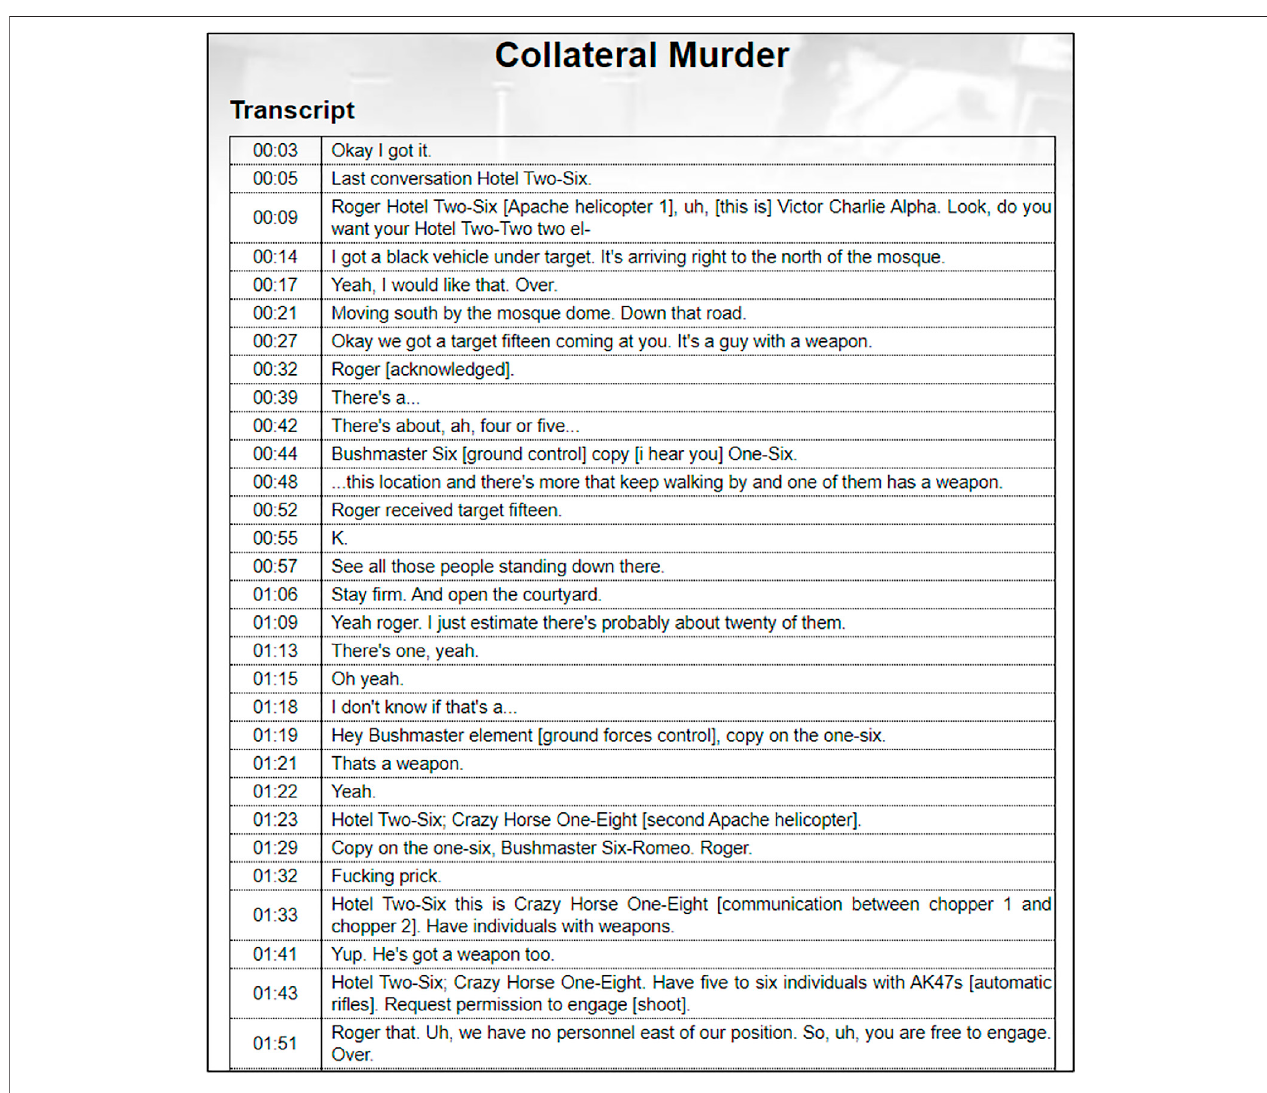
FIGURE 8 | Wikileaks ’ Collateral Murder transcript — Opening